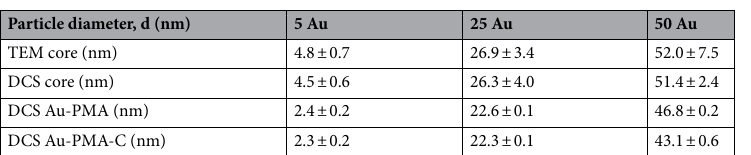
Table 1. Average NP diameter and standard deviation of the gold NPs prior to and after exposure with the biological fluid, measured by different characterisation methods. Particle diameters obtained from DCS measurements assumed a particle density of 19.3 g cm -3